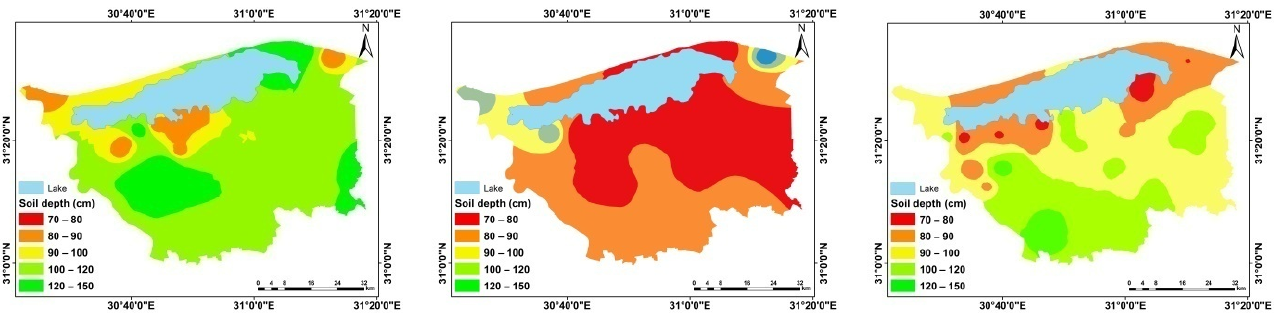
Figure 7. Soil depth maps in 1961, 2002, and 2016.